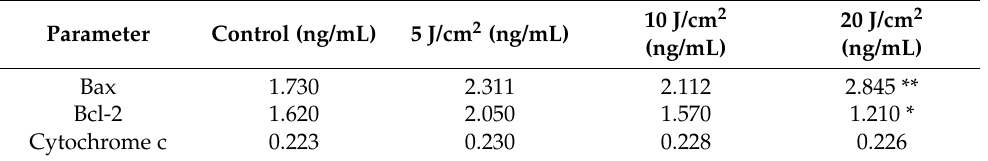
Table 1. The enzyme immunoassay measurement of Bax, Bcl-2 and cytochrome c proteins showed increased Bax expression compared to Bcl-2 and cytochrome c release across all the experimental groups. Significance differences were presented as * p < 0.05, ** p < 0.01.